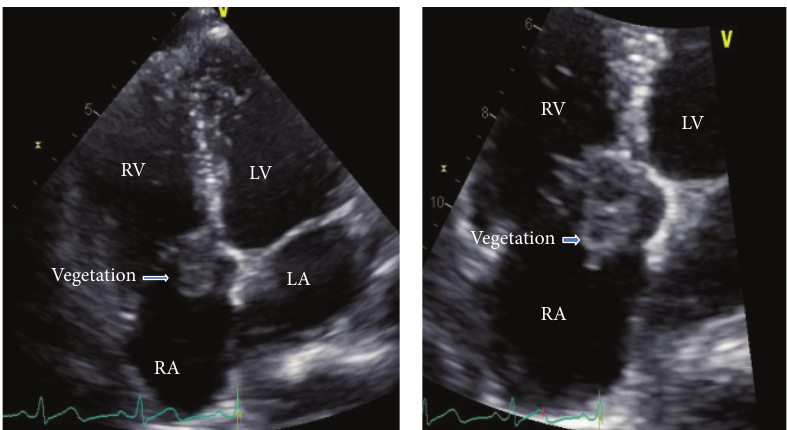
Figure 1: Transthoracic echocardiogram: four chambers’ view of the heart showing large vegetation attached at tricuspid valve along right atrial surface. RA: right atrium; LA: left atrium; RV: right ventricle; LV: left